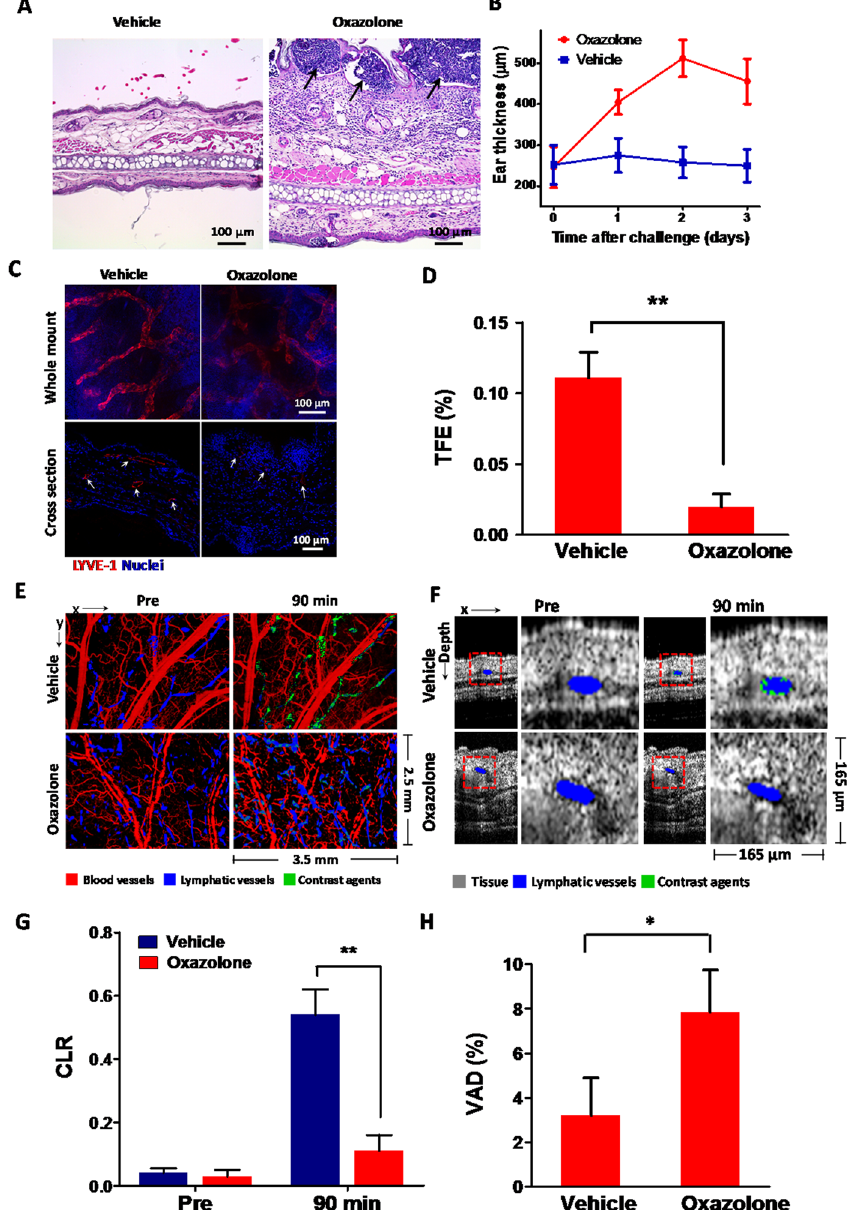
Figure 5. LYVE-1 imaging with CHS induced inflammation mouse models. ( A ) The hematoxylin and eosin (H&E) staining of control and inflamed mice ears after two days of OXA treatment. Arrows indicate the locations of intraepidermal abscesses. ( B ) The thickness of the vehicle- and OXA-treated mice ears monitored at different days post-challenge. ( C ) Representative fluorescent microscopy images show the immunohistochemical (IHC) staining of LYVE-1 (Alexa 594-anti-LYVE-1, red) and nuclei (DAPI, blue) in whole-mount and cross-sectional tissue sections of control and inflamed mice ears after 2 days of OXA treatment. The paired fluorescent images of vehicle- and OXA-treated ear tissues were captured by confocal microscopy with identical illumination and acquisition parameters. The whole-mount fluorescent images were obtained as maximum intensity projections of 50 confocal images scanned over a tissue depth of 100 μ m. Arrows in the cross-sectional images indicate the IHC staining of LYVE-1 along the lymphatic endothelium. ( D ) Total fluorescence efficiency (TFE) of LYVE-1 in the IHC whole mount images. Data pooled over 1000 images of tissue sections from 3 vehicle-treated and 3 OXA-treated mice. ** P = 0.00074 (unpaired t -test). ( E ) En face projection images of angiogram (red), lymphangiogram (blue), and lymphatic contrast (green) signals of vehicle- and OXA-treated mice pinnae at pre-injection and 90 min post-injection of contrast agents. ( F ) Transverse images of ear tissue microstructure (gray), lymphangion (blue), and lymphatic contrast agents (green) of vehicle- and OXA-treated mice pinna at pre-injection and 90 min post-injection of contrast agents. ( G ) CLRs of vehicle- and OXA-treated ears at pre-injection and 90 min post-injection after 2 days of OXA challenge. Bars show means ± SEM, n = 4 mice; ** P = 0.00091. ( H ) Lymphatic vessel area density of vehicle- and OXA-treated mice ears at 2 days post-challenge. Bars show means ± SEM (n = 4 mice). * P =